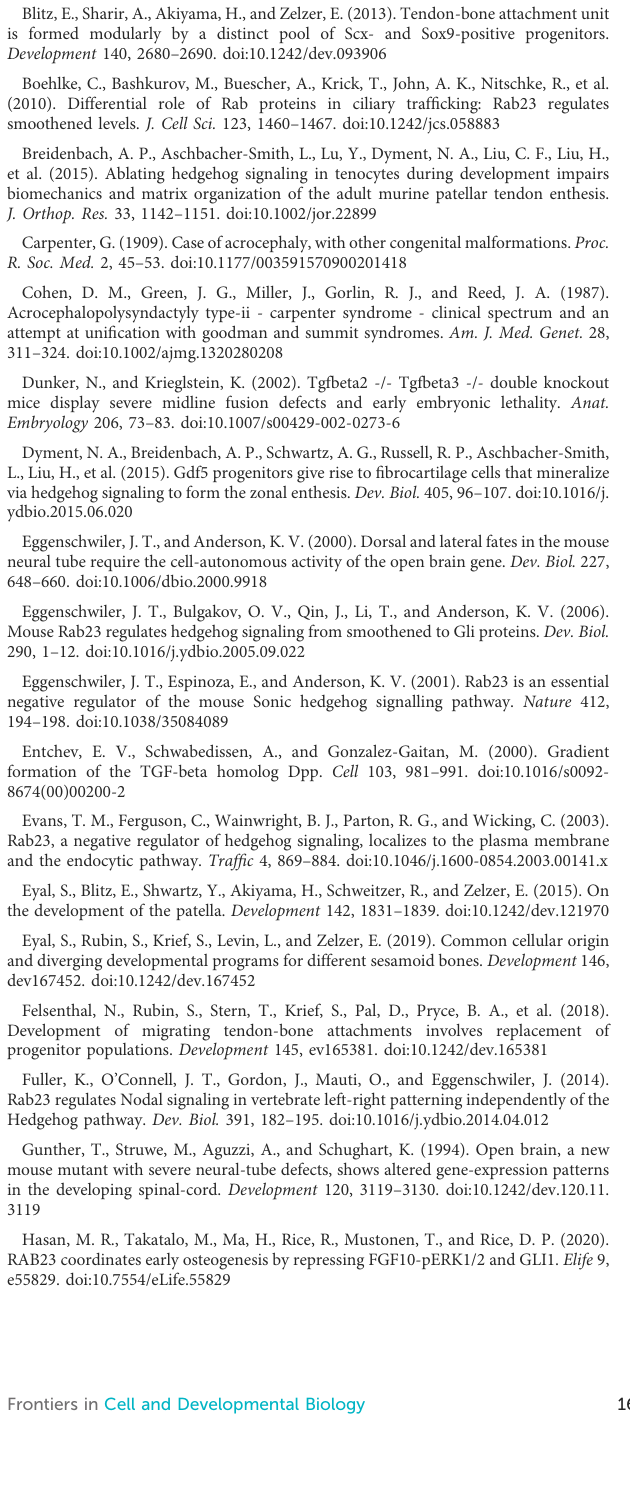
SUPPLEMENTARY FIGURE S4 COL2A1 expression analysis in Wt and Rab23 − / − patellofemoral samples. Image shows the staining of the chondrocyte marker COL2A1 in Wt and Rab23 − / − samples at E15.5 and E17.5. COL2A1 shows more prominent expression in the articular cartilage toward the femur and tibia heads in Rab23 − / − samples (white arrow), while the Wt samples exhibit a more uniform expression of COL2A1 throughout the femur and tibia heads. (n = 3 for each age and genotype). ac: articular cartilage, f: femur, t: tibia, and p: patella. Scale bar: 200 µm. SUPPLEMENTARY FIGURE S5 Rab23 − / − mice show malformed deltoid tuberosity in the forelimbs Alizarin red (bone) and Alcian blue (cartilage) staining of WT and Rab23 − / − mice at